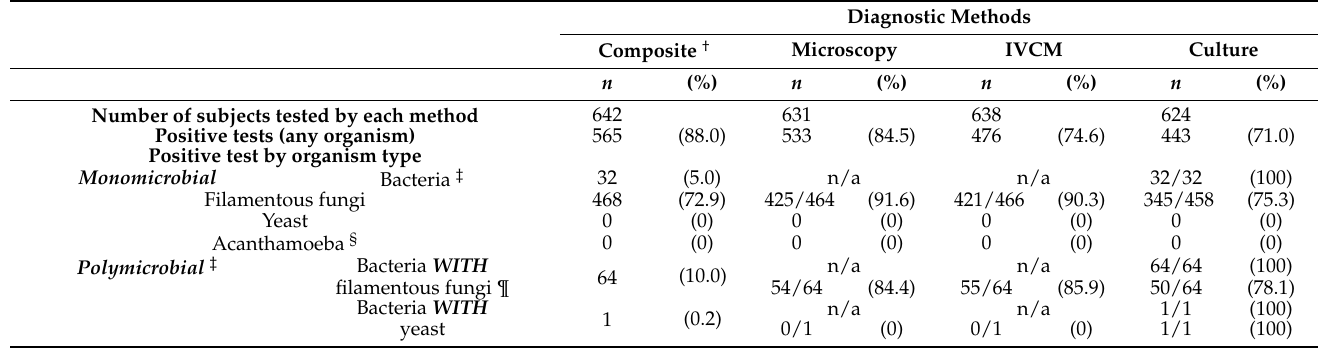
Table 1. Microbial aetiology for 642 keratitis patients categorised by group of organism and diagnostic techniques, both separately and for the composite diagnosis using all methods combined.